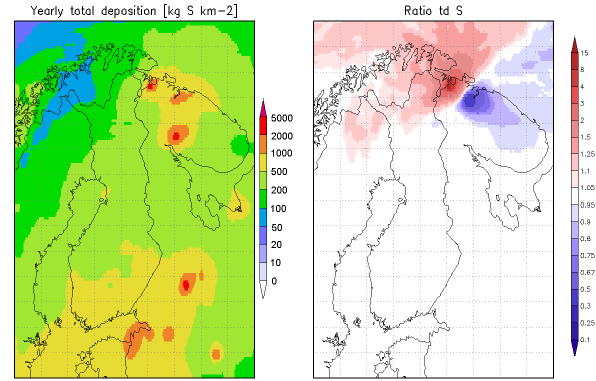
Fig. 11. Left panel: Total annual sulphur deposition after emis- Figure 11. Panel a: Total annual sulphur deposition after emission correction, [mg S m-2], panel b: ratio of total sulphur depositions D before sion correction, [mgSm − 2 ], right panel: ratio of total sulphur de- and after emission correction Drevised / Doriginal, [relative units], mean over the years 2003 and 2006. positions D before and after emission correction D revised / D original , [relative units], mean over the years 2003 and